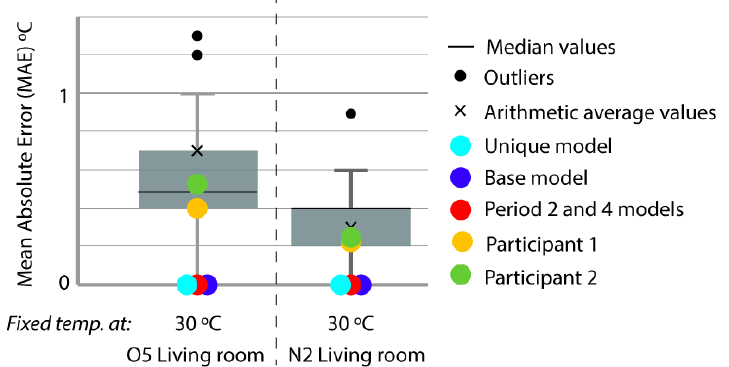
Figure 6. Temperature MAE for Period 2 (fixed set point at 30 ◦ C).